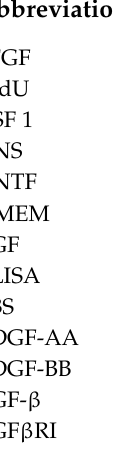
Figure S1: The e ff ects of TGF- β 1 and CSF on EOC 2 and SIM A9